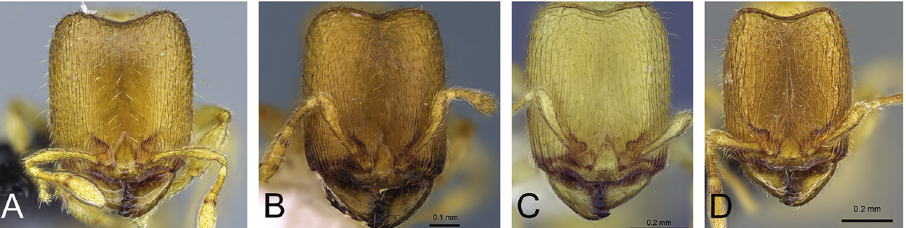
Figure 9. Head in full face view of A Carebara nosindambo (CASENT0072626) B Carebara tana (CASENT0437819) C Carebara dota (CASENT0192623) D Carebara hainteny (CASENT0039833). 10 In full-face view, head without transverse rugae near posterior margin of head, mandible with six teeth (Fig. 9A) ..................................................... 11 – mandible with five teeth (Fig. 9B) ............................................................. 12